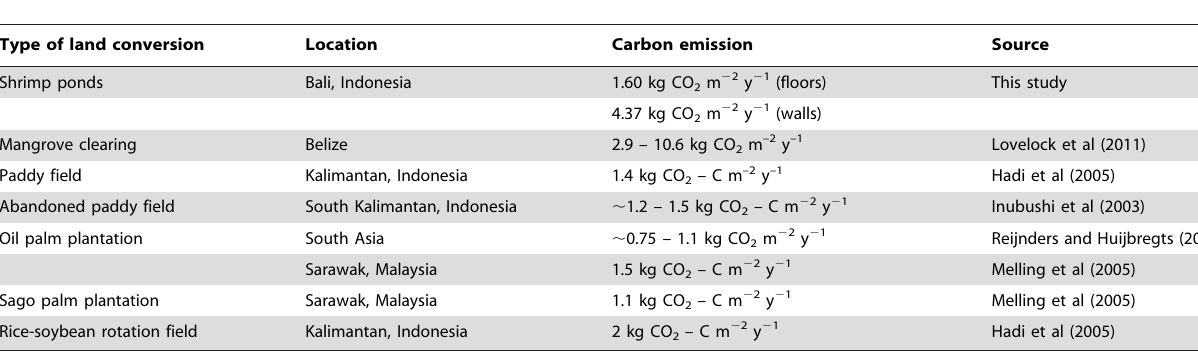
Table 1. Comparison of CO 2 emissions from land uses linked to tropical forest